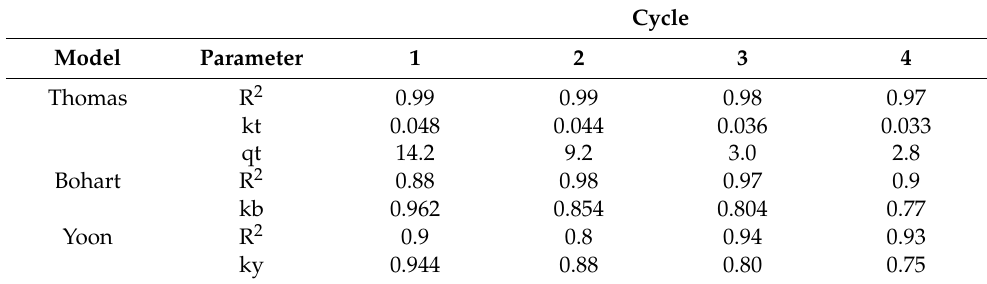
Table 11. Summary of the experiments obtained with ECFe material in the process of